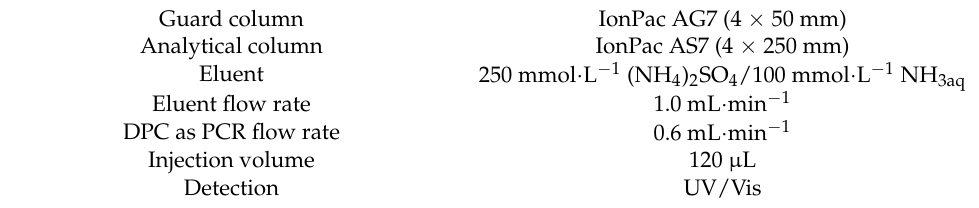
Table 3. Separation conditions for the ion chromatograph ICS-3000, Dionex [17].